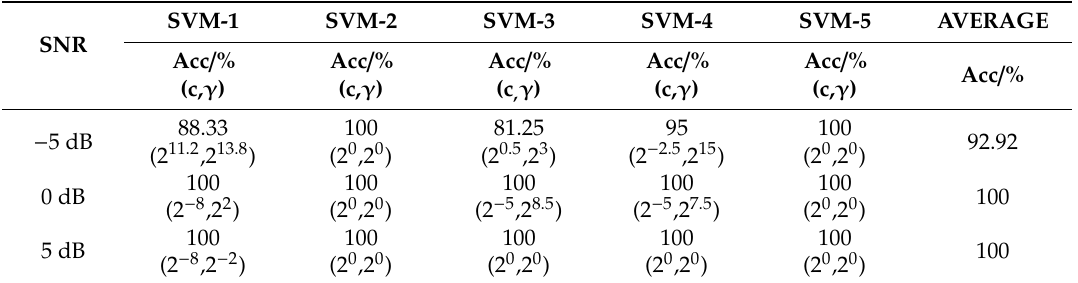
Table 5. The optimization results and identification accuracy of the sub-SVM of each node in DT–SVM.